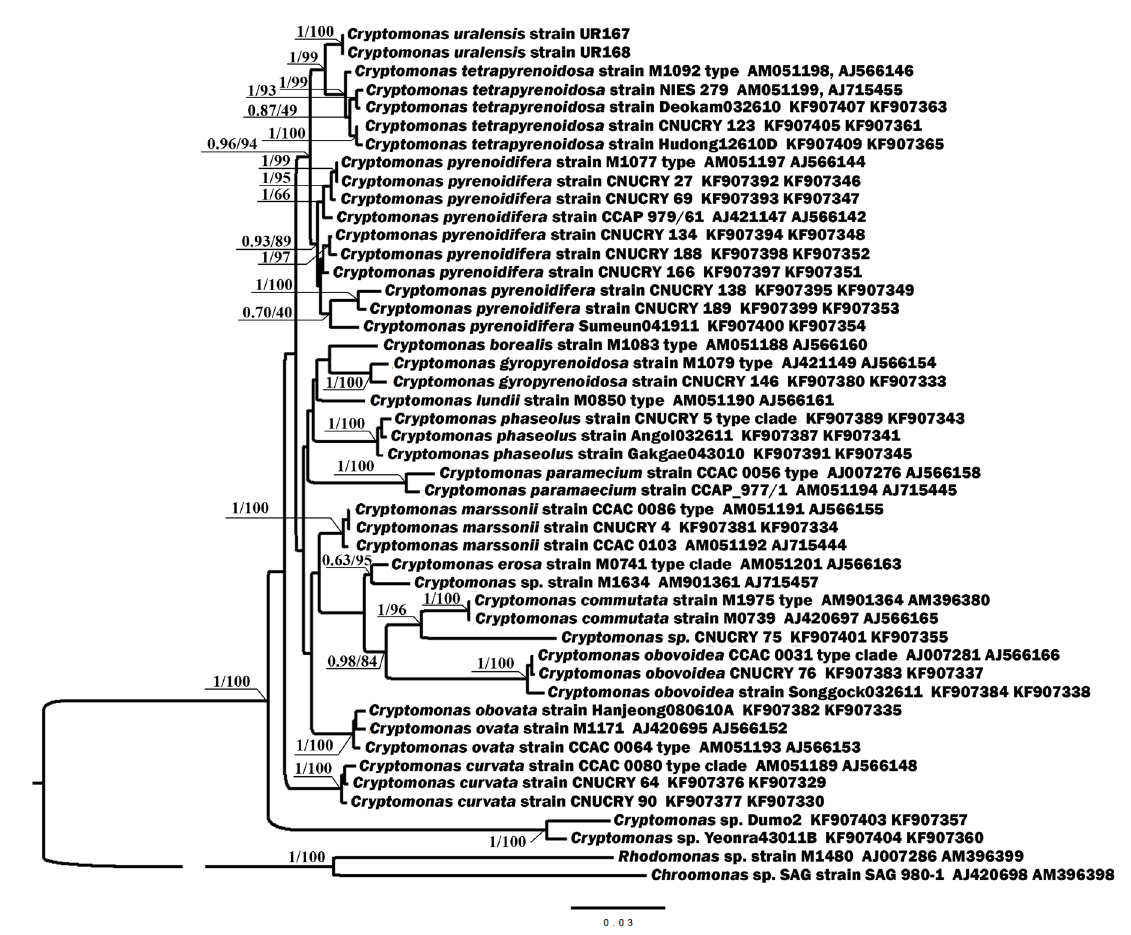
Fig. 13. Bayesian phylogenetic tree of the partial small subunit rDNA (SSU rDNA) and large subunit ribosomal DNA (LSU rDNA) combined data set. The Bayesian posterior probability (left) and maximum likelihood bootstrap value (right) are shown. Scale bar represents estimated number of substitution per